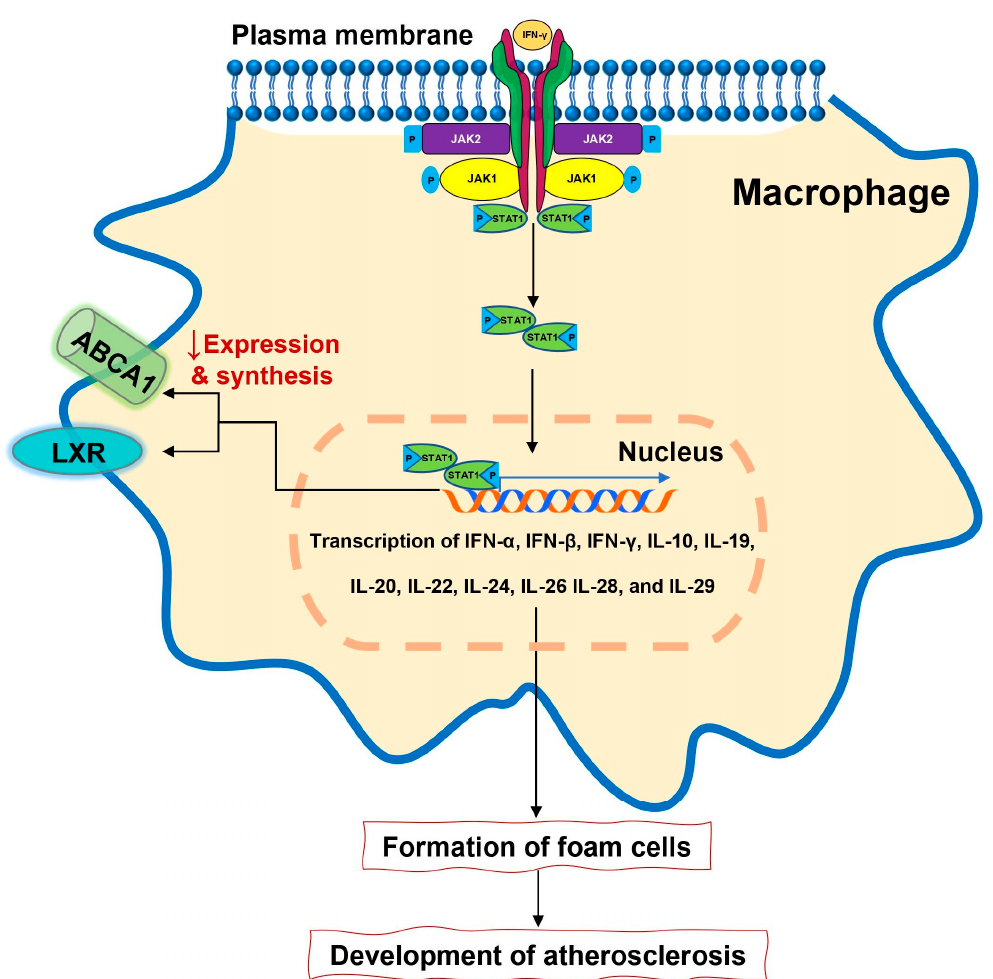
Figure 3. Interferons after ligating to type II receptors activate JAK/STAT pathway resulting in foam cells formation leading directly to atherosclerosis development. That same pathway that transmits signals from interferons contributes to reduced expression of the liver X receptor and decrease synthesis of ATP-binding cassette transporter leading to pro-atherosclerotic lipid